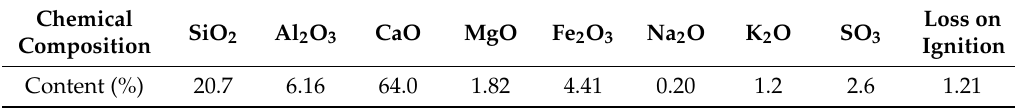
Table 1. Chemical composition of the cement (% wt.).